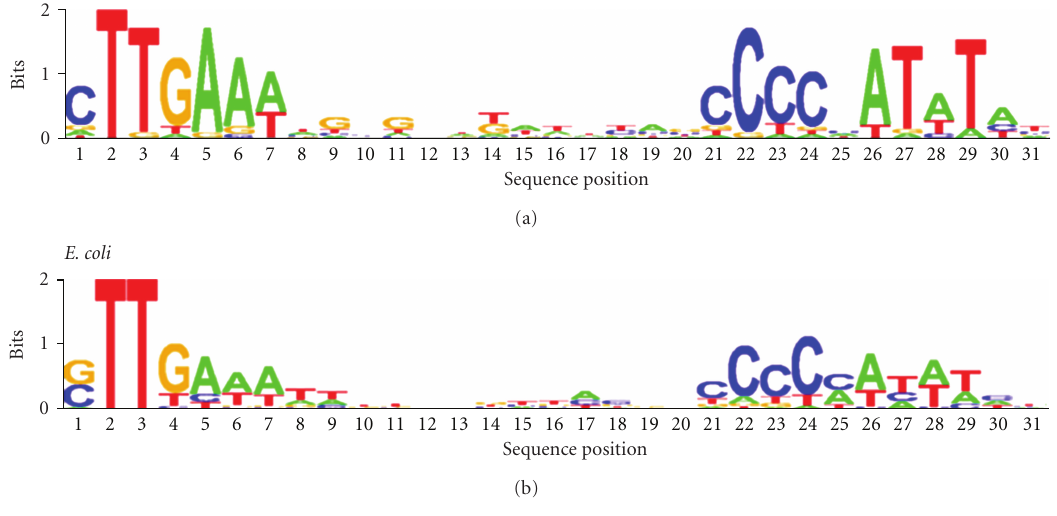
Figure 1: Comparison of consensus σ 32 -recognition sequences of E. coli and S. oneidensis . The E. coli and S. oneidensis sequences used were from the published reports by Nonaka et al. [22] and Gao et al. [20], respectively. The sequences were initially aligned by clustalx and the sequence logo was prepared using public software at